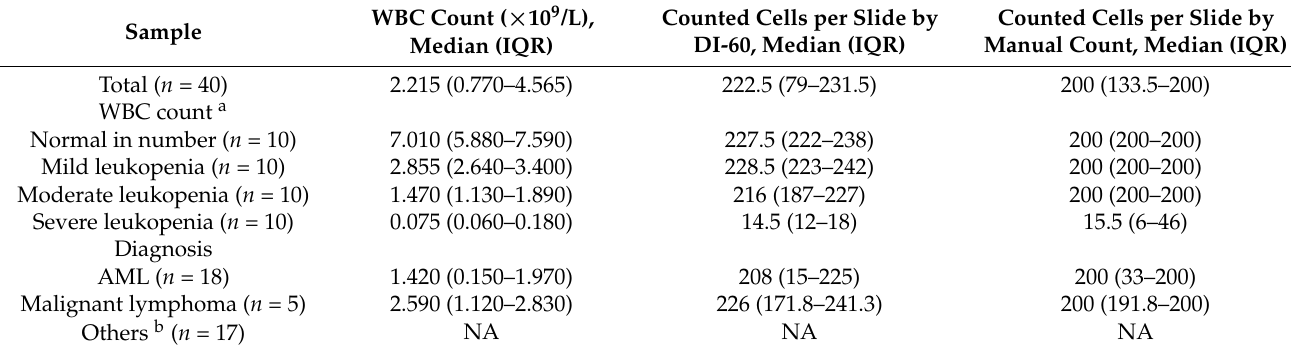
Table 1. Study population and counted cells per slide of samples by DI-60 and manual count.